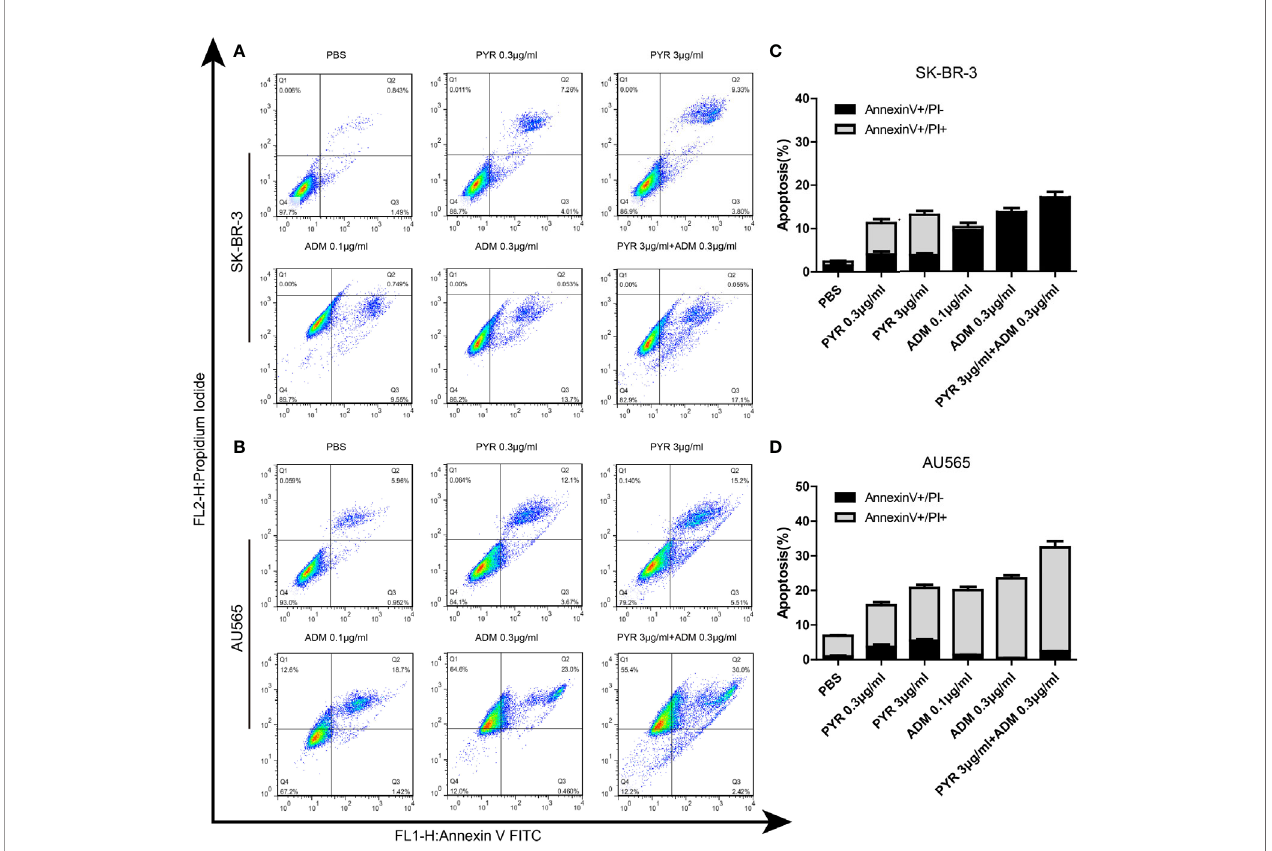
FIGURE 4 | Effects of PYR and ADM on cell apoptosis. (A, B) Cell apoptosis was detected through Annexin V-FITC/PI double staining and following fl ow cytometry for SK-BR-3 cells after incubated with PBS, different concentrations of PYR(0.3, 3 m g/ml), ADM(0.1, 0.3 m g/ml) or a combination treatment(PYR+ADM) for 24 h. (C, D) The histograms were the representative results, while the fi gure in the right. Compared to the control, PYR combined with ADM induces apoptosis in SK-BR-3 and AU565 cells. Data represent the mean ± S.D. of three independent